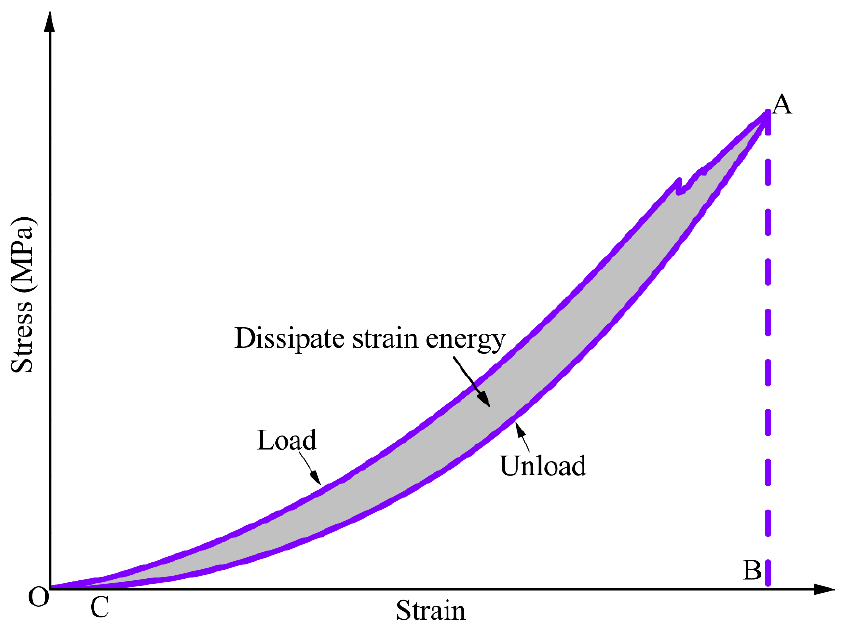
Figure 2. Rock unloading stress–strain